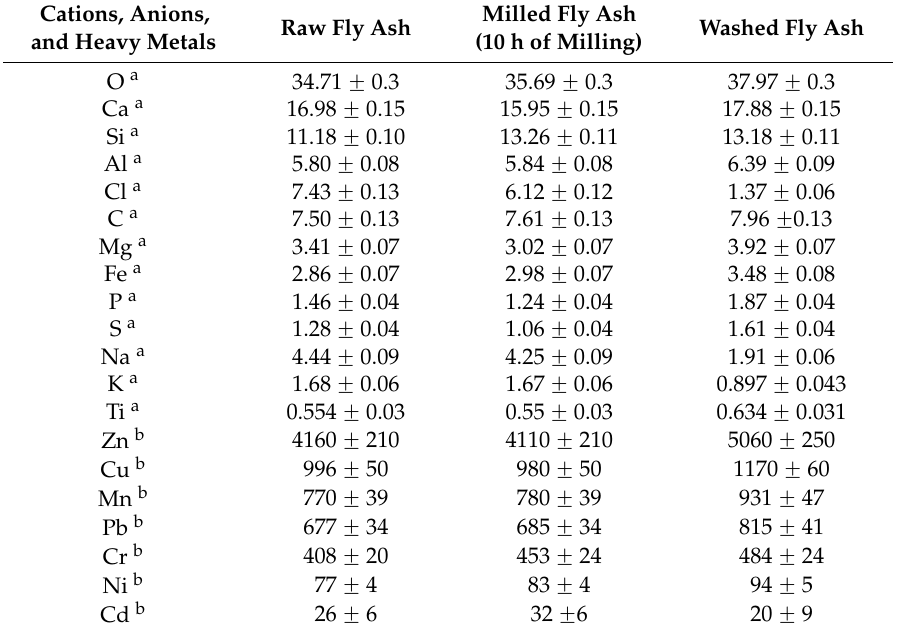
Table 2. The main cations, anions, and heavy metals in the fly